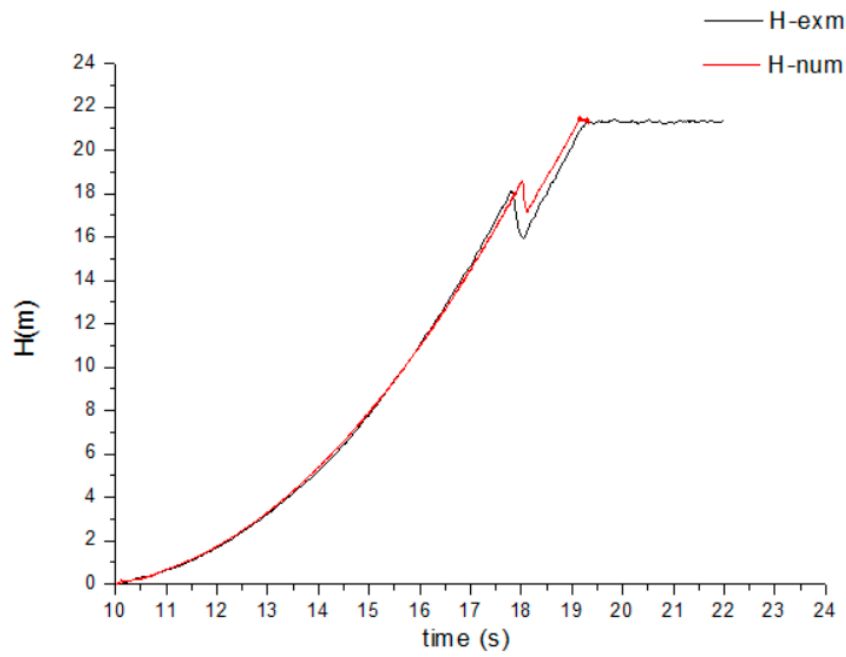
Figure 15. Comparison of the experiment and simulation heads.